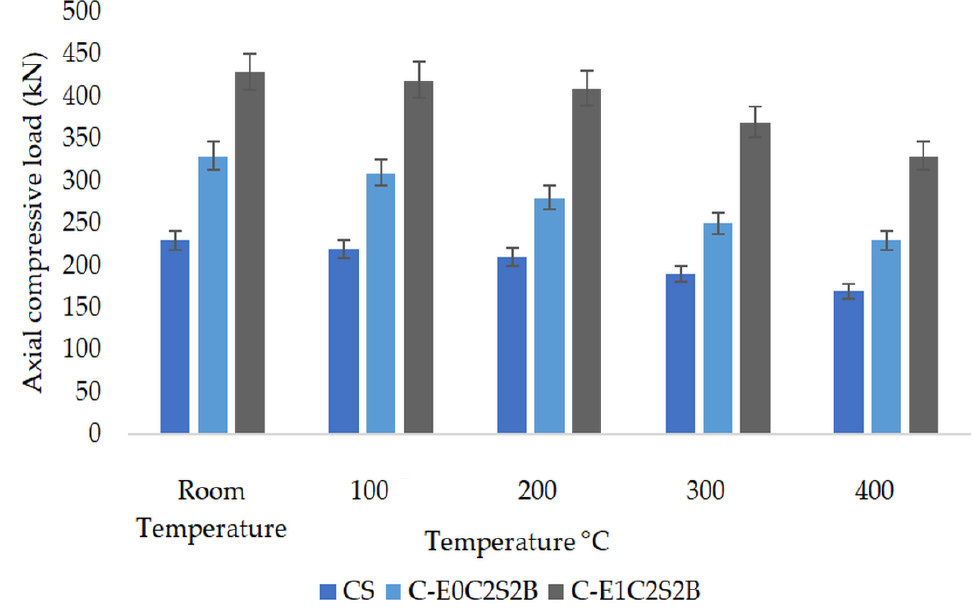
Figure 10. Maximum compressive load of unconfined and HSBFRP specimens exposed to elevated temperatures. Table 6. Compression test results of HSBFRP-confined exposed to elevated